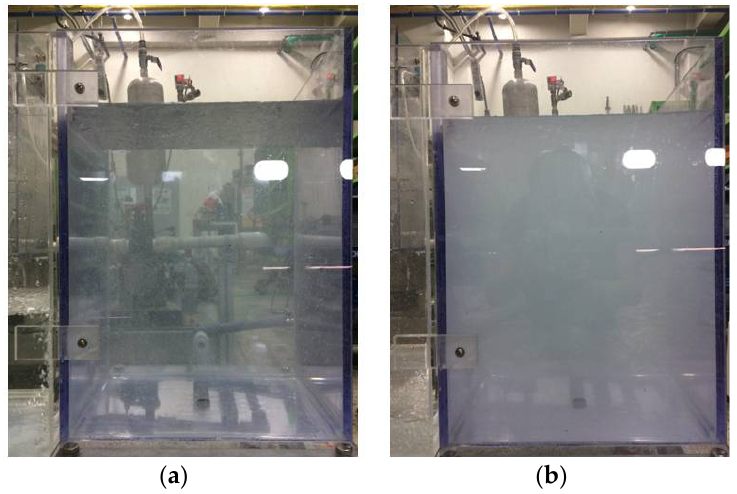
Figure 9. Picture of microbubbles: ( a ) pump pressure of 4 bar and air flowrate ratio of 3.2 percent; ( b ) pump pressure of 5 bar and air flowrate ratio of 4.0 percent.